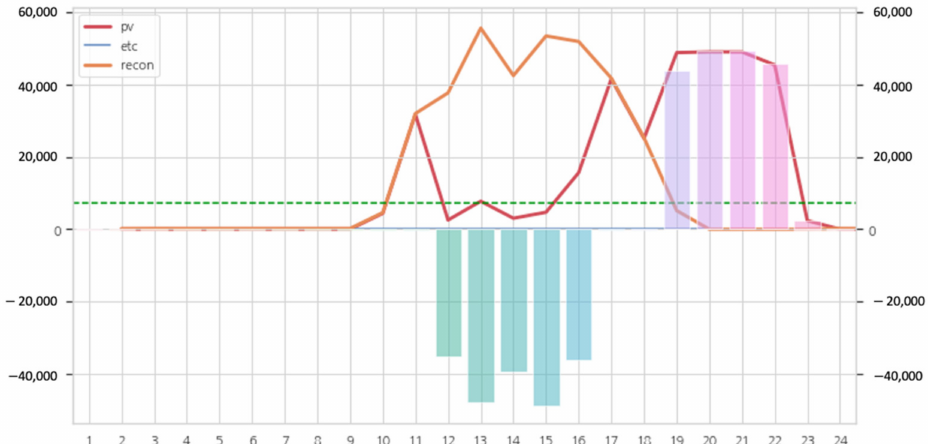
Figure 5. Integrated PV plus BESS system outputs (red line). BESS is set to be charged during the daytime (downside bars), when the PV output (orange line) exceeds the threshold (green dotted line). The discharging (upside bars) starts after 19:00 to maximize incentives for reducing the duck curve. X axis means hour, and Y axis means power output in MW.